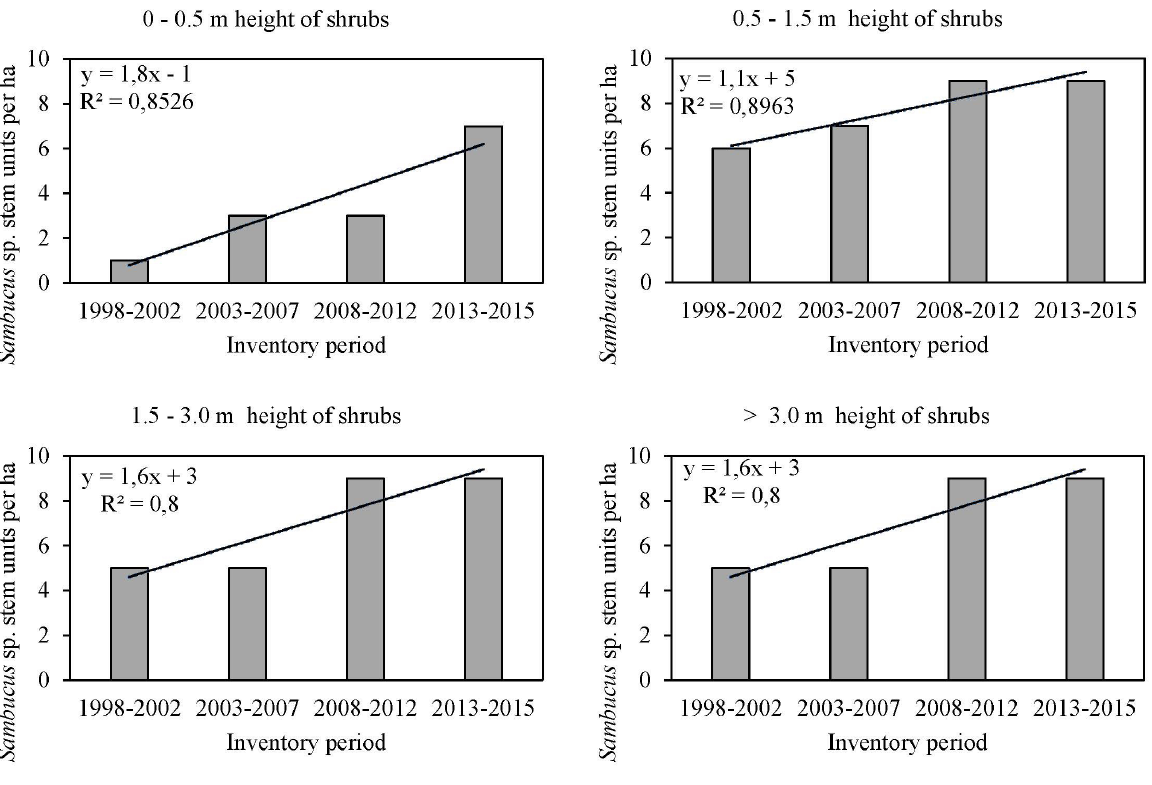
Figure 6. Dynamics of Sambucus sp. abundance in 1998-2015 years according different height groups of shrub layers and number of individuals per ha. The abundance of Sambucus species was highest in the stands to 20 years old. In the period of 2013-2015 they reached more than 60 stem units per ha. The abundance of Sambucus sp. was lower in the 20-60 years old stands (up to 30 stem units per ha). The lowest abundance of Sambucus was in mature stands (61-120 years old). The abundance of Sambucus sp. has increased in different age stands since 1998. The highest increase was observed in 2012-2015 in young stands (0-20 years old;